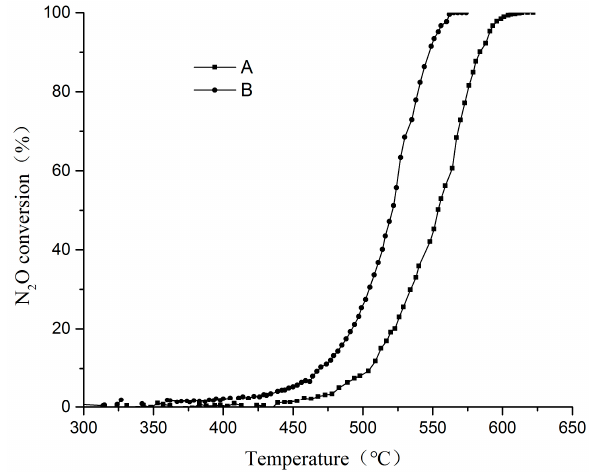
Figure 6. Conversion of N 2 O over Cu–Zn/ γ –Al 2 O 3 catalysts. Reaction conditions: (A) 12% vol N 2 O, 16.8% vol O 2 , N 2 balance; GHSV (gas hourly space velocity) = 7200 h − 1 ; (B) 12% vol N 2 O, 16.8% vol O 2 ,